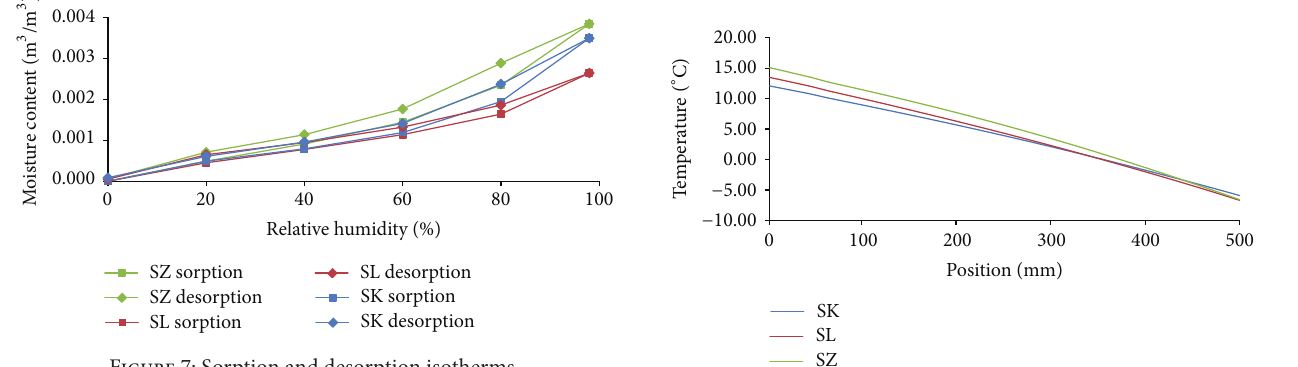
Figure 9: Temperature profiles, ˇSer´ak’s climatic conditions, January 15, 3:00